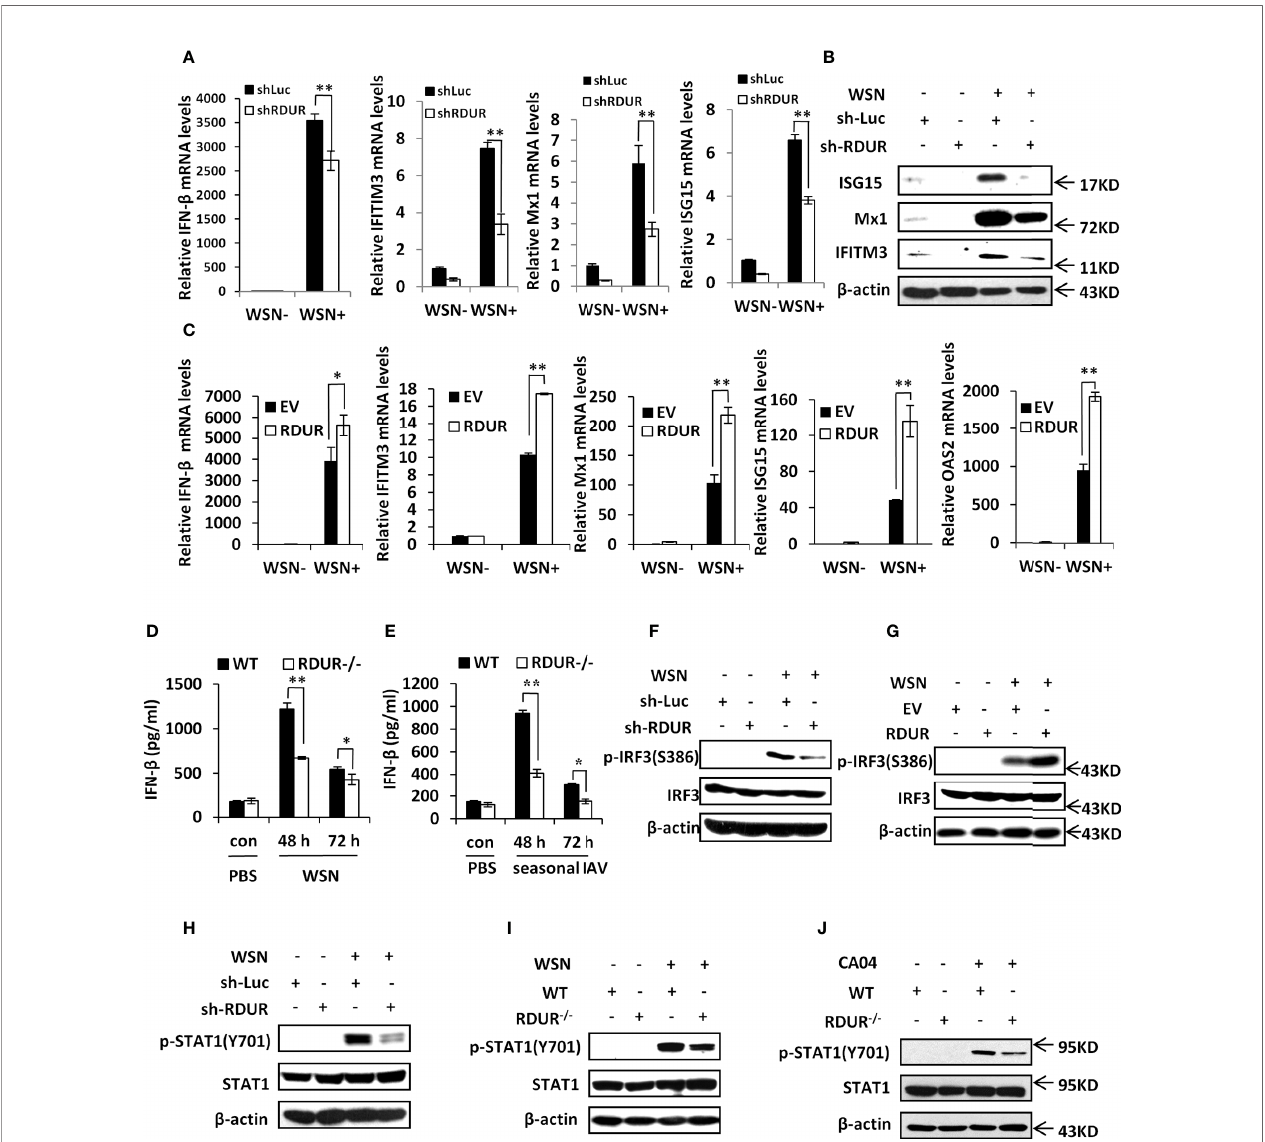
FIGURE 6 | RDUR regulates the expression of several critical antiviral genes in vitro and in vivo . (A) The levels of IFN- b , IFITM3, Mx1 and ISG15 were examined by qRT-PCR in A549 cells expressing shRNAs speci fi cally targeting RDUR or luciferase (control) after infection with or without WSN. Plotted are the average levels from three independent experiments. Data are shown as means ± SD. ** P < 0.01. (B) A549 cell lines stably expressing speci fi c shRNAs targeting RDUR and luciferase (control) were infected with or without WSN and harvested at 16 hpi, followed by Western blotting with the indicated antibodies. Shown are representative data from three independent experiments with similar results. (C) The mRNA levels of IFN- b , IFITM3, Mx1, ISG15 and OAS2 in RDUR over-expression and empty vector (EV) control A549 cells infected with or without WSN were determined by qRT-PCR. Plotted are the average levels from three independent experiments. Data are shown as means ± SD. * P < 0.05, ** P < 0.01. (D, E) The protein levels of IFN- b were determined by ELISA in the lungs of mRDUR knockout or WT mice infected with WSN or seasonal IAV (3 mice each group). Plotted are the average levels from three independent experiments. Data are shown as means ± SD. * P < 0.05, ** P < 0.01. (F) RDUR knockdown and control A549 cells were infected with or without WSN, and Western blotting was performed to detect indicated proteins. (G) RDUR overexpression and EV control A549 cells were infected with or without WSN and examined by Western blotting with the indicated antibodies. (H) A549 cell lines stably expressing speci fi c shRNAs targeting RDUR and luciferase (control) were infected with or without WSN and examined by Western blotting with the indicated antibodies. (I, J) mRDUR knockout and control mice were infected with WSN or CA04 in fl uenza virus. Western blotting was performed by using indicated antibodies. Shown are representative immunoblots from three independent